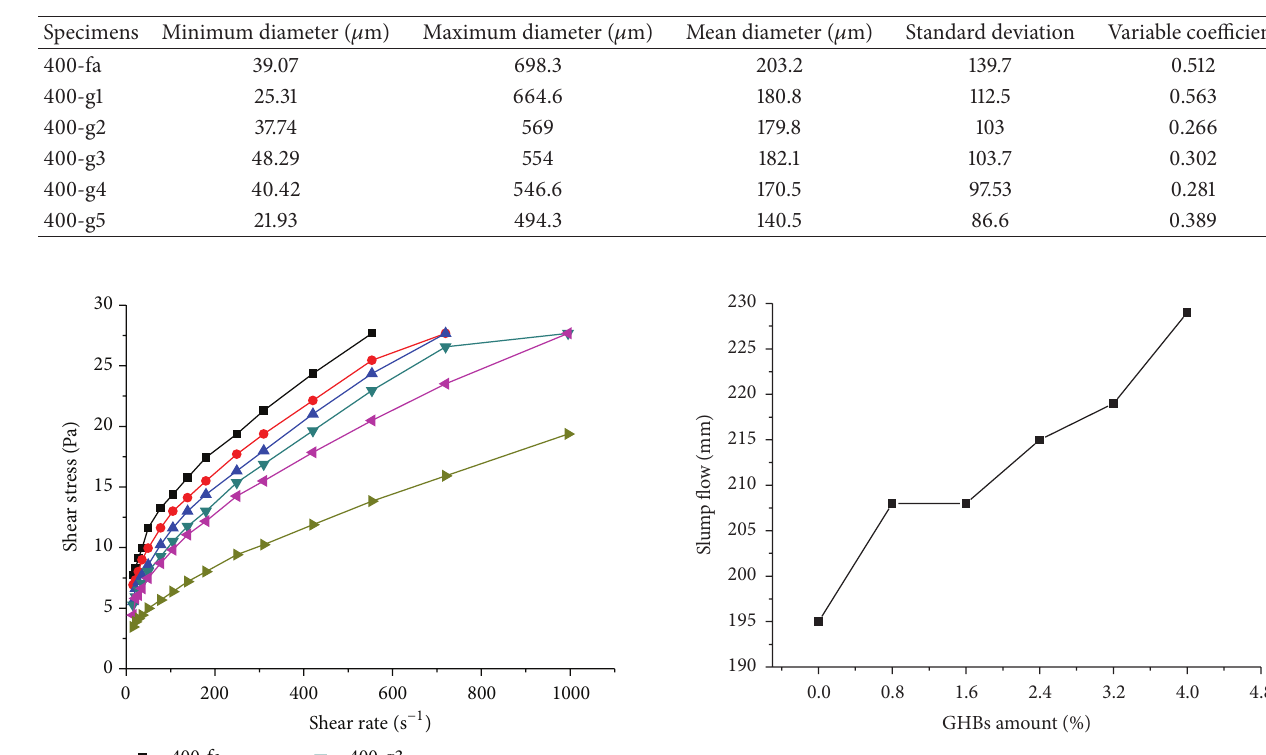
Table 3: Characteristics of air voids of the test specimens.